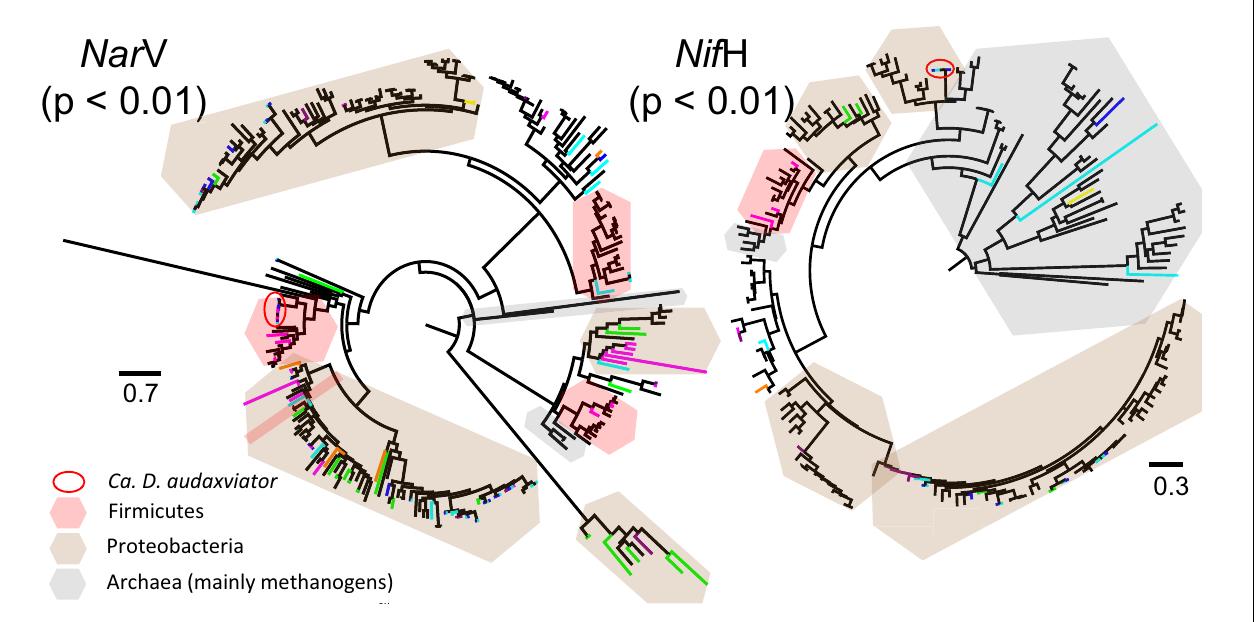
FIGURE 4 | Maximum likelihood trees of deduced amino acid sequences of Nar V and Nif H genes detected in assembled metagenomes. Sequences from this study are highlighted by color lines, with blue for BE2011, cyan for BE2012, orange for DR5, green for FI88, magenta for TT107, dark purple for TT109, and yellow for MM5. P -test significance values of unweighted UniFrac distances among metagenomes are given. Scale bars